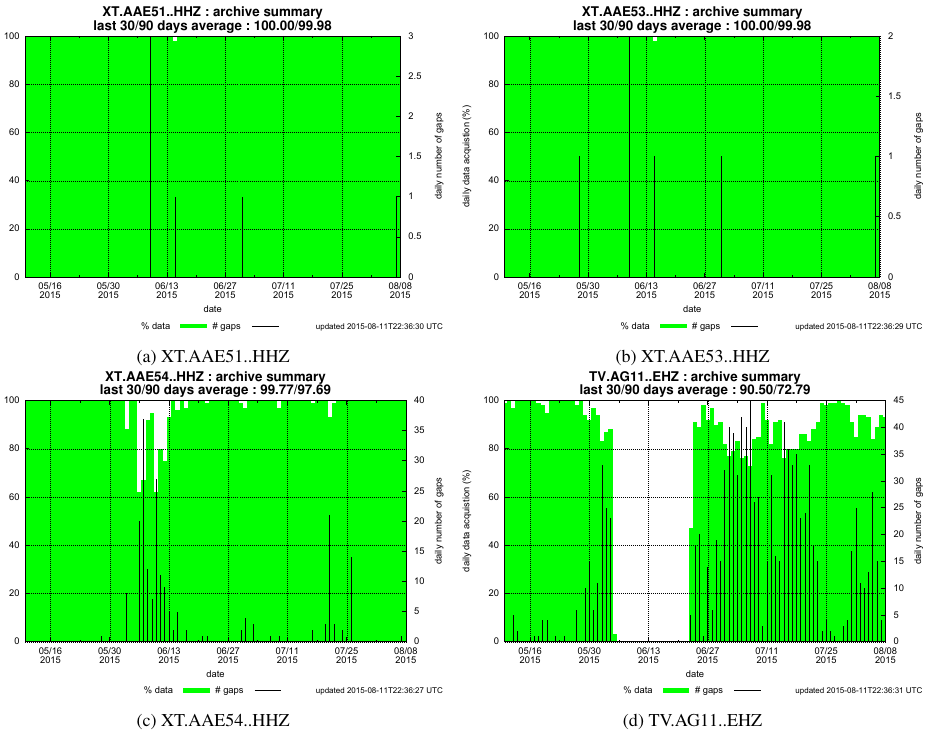
Figure 4. The data acquistion status of some real-time UMTS stations currently installed. Green boxes represent the daily percentage of data present in the archive, while black impulses represent the number of gapsday − 1 normally related to UMTS service problems. Panels (a) to (c) show results for three broad-band stations belonging to the EASI transect (Plomerova et al., 2015). They have been working remarkably well since August 2014 scoring an overall 99.97% of real-time data acquisition, only the XT.AAE54. (c) is showing some connection problem in the second week of Jun 2015 with peaks of 30–35gaps in a day. The worst case is in (d) . This station is sited in a rural area of the Val D’Agri (Southern Italy) with a very low signal level (less than − 100dB). After several days with 20–30gapsday − 1 , the UMTS router just stopped connecting. When the station was serviced and the router rebooted, data acquistion started again but with a very high number of daily gaps and an unsatisfactory average 90% daily data acquisition